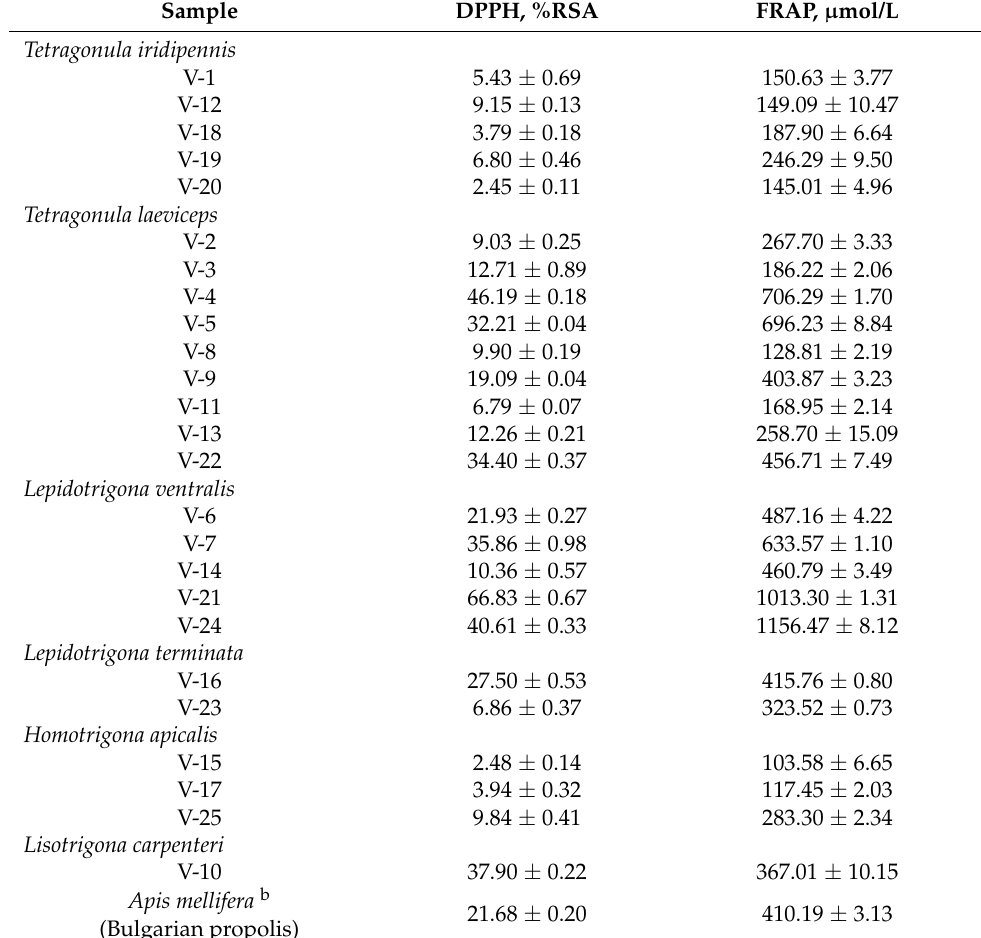
Table 2. DPPH and FRAP for Vietnamese stingless bee propolis a